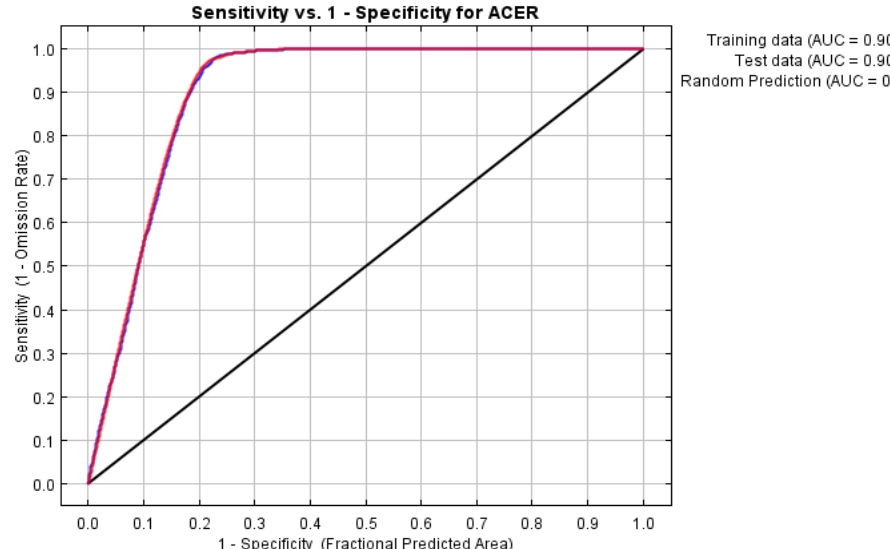
Figure 4. MaxEnt model performance for the Montpellier Maple (the Area Under Curve (AUC) parameters show an excellent performance with a value higher than 0.9).